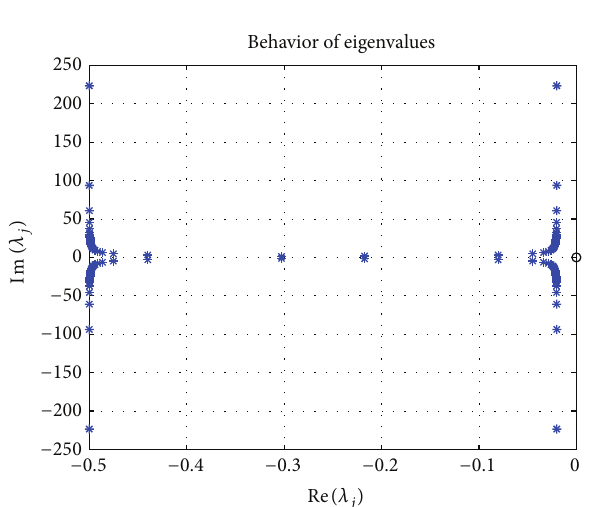
Figure 7: Δ𝑡/Δ𝑥 = 0.9600